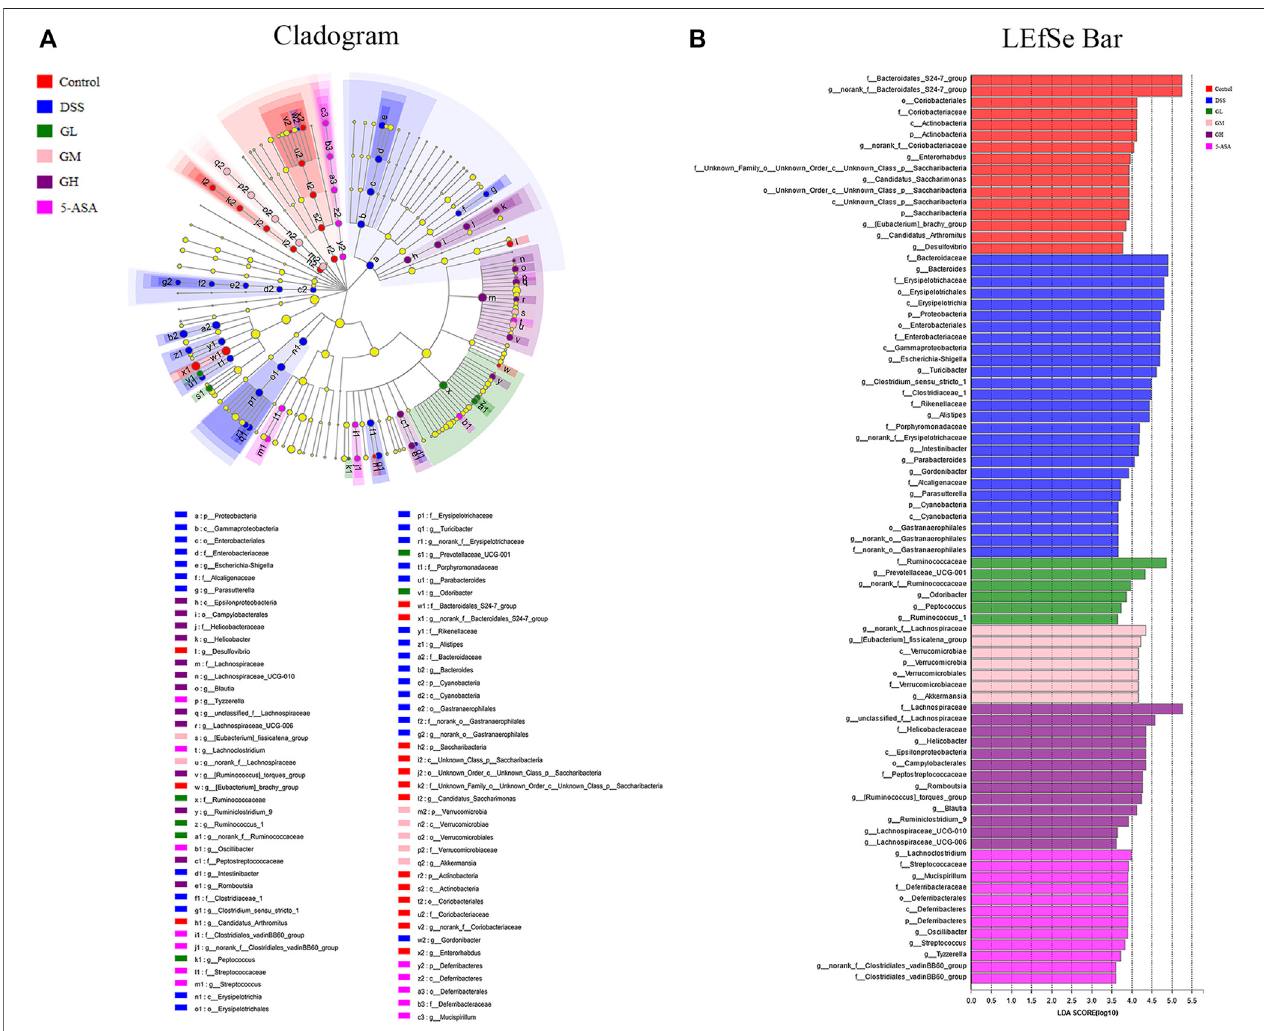
FIGURE 5 | Screening of differentially abundant microbial taxa using linear discriminant analysis (LDA) coupled with effect size (LEfSe) analysis. (A) Taxonomic cladogram obtained from LEfSe analysis of 16S sequences. Yellow dots indicate no statistical signi fi cance. (B) Distribution histogram based on LDA, with a log LDA score above 3.6. The LDA histogram showed signi fi cant differences in species, which were all greater than the preset value. The color of the histogram represents each group, and the length of the histogram can express the degree of in fl uence of species with signi fi cant differences between different groups.